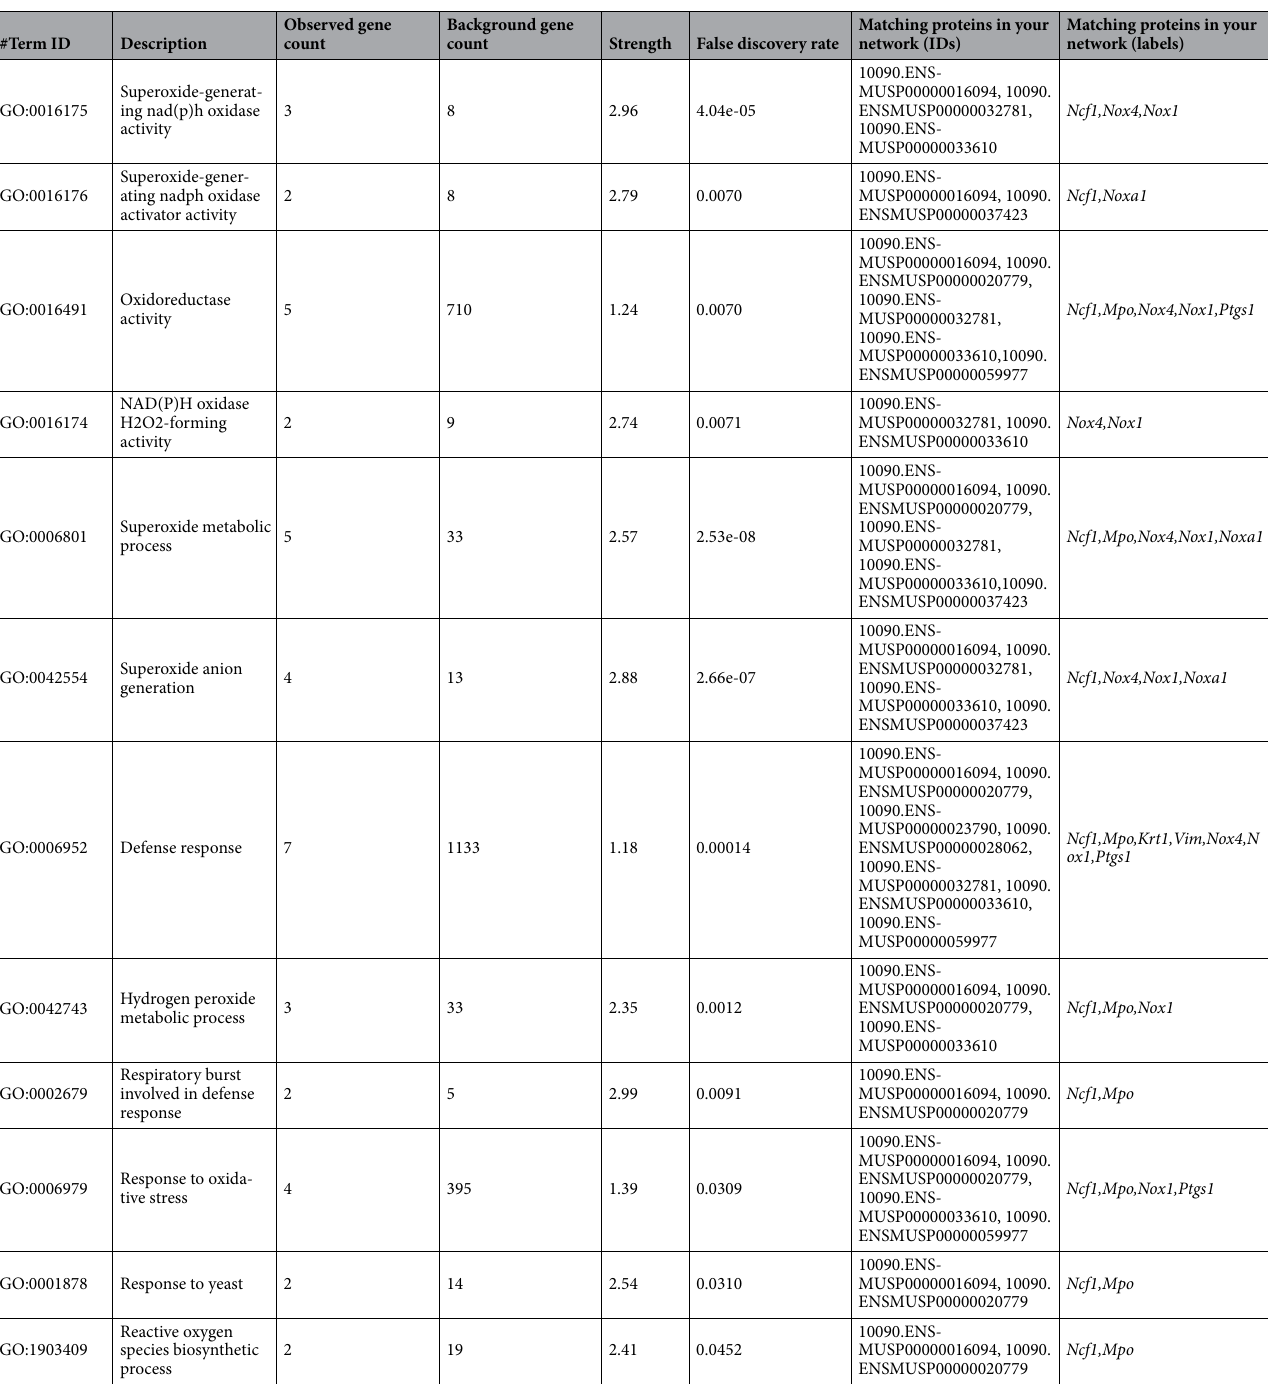
Table 1. Function and process pathway analysis by using the GO data base of cluster